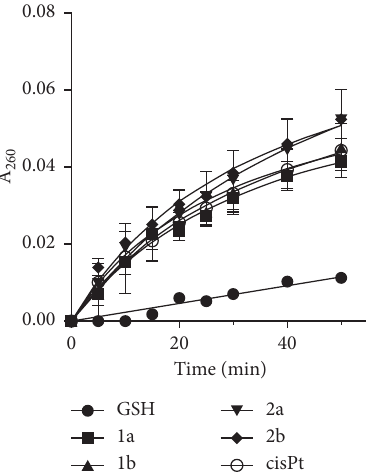
Figure 6: UV absorbance associated with the reaction of complexes 1a , 1b , 2a , 2b , and cisplatin with GSH. Absorbance at 260nm is shown as a function of time. The curves represent absorbances of the solution containing platinum complex plus GSH, from which the absorbance yielded by the Pt complex and GSH at t � 0 was subtracted. All results are expressed as the mean ± SD from two independent experiments, each performed in Figure 7 demonstrates concentration-dependent